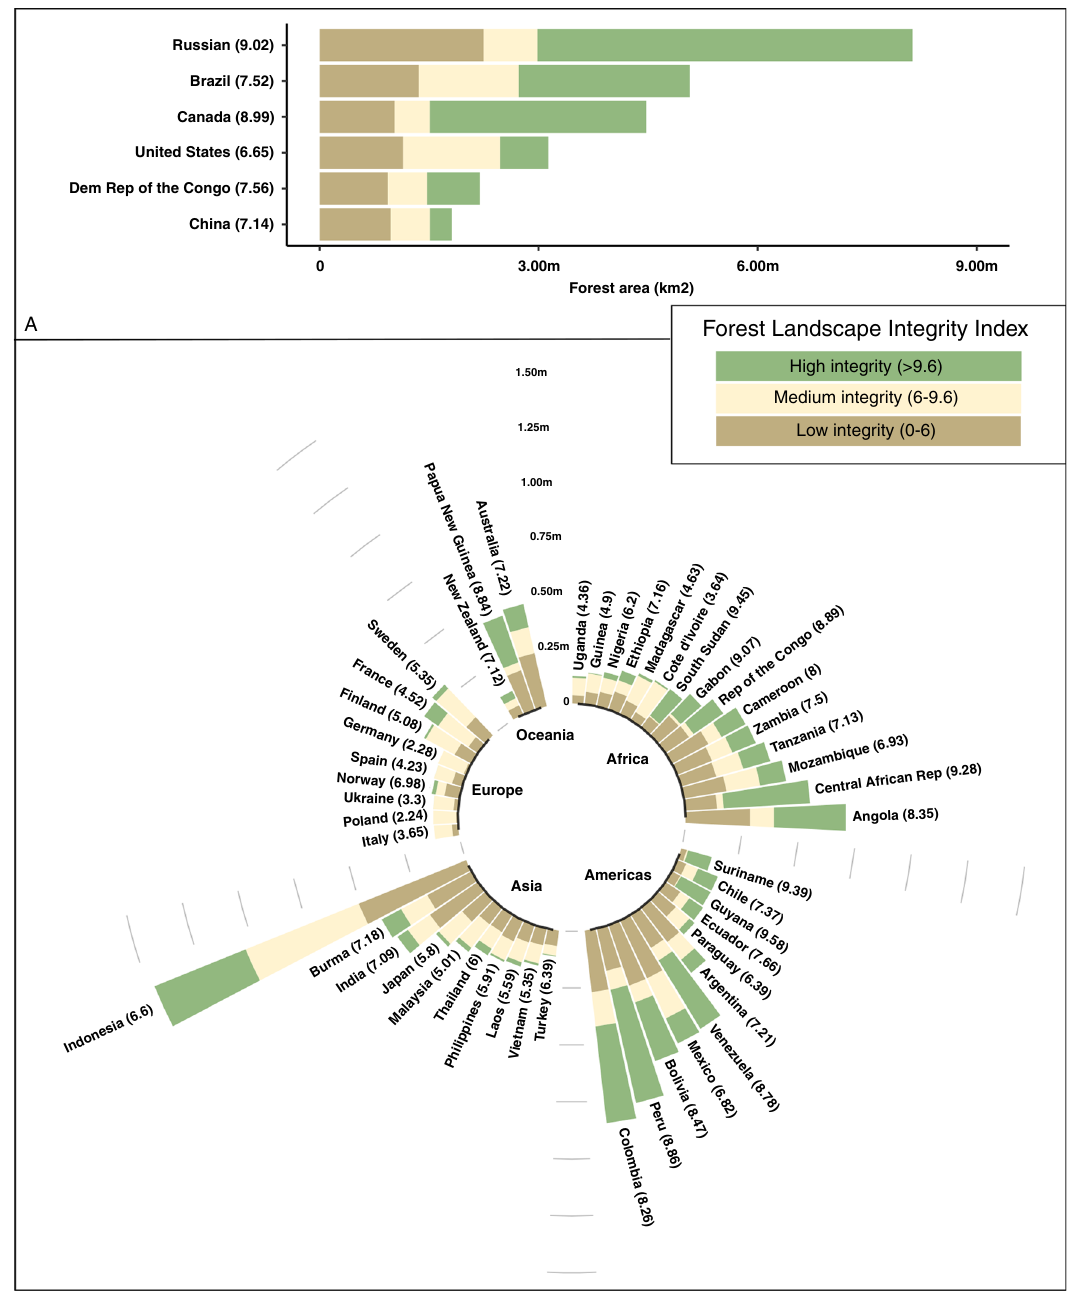
Fig. 4 Forest Landscape Integrity Index map categorized into three illustrative classes for each major forested country. The Forest Landscape Integrity Index for 2019 categorized into three broad, illustrative classes for each major forested country in the world. ( a ) countries with a forest extent larger than 1 million km 2 , and ( b ) countries with forest extent between 1 million km 2 and 100,000 km 2 of forest. The size of the bar represents the area of a country ’ s